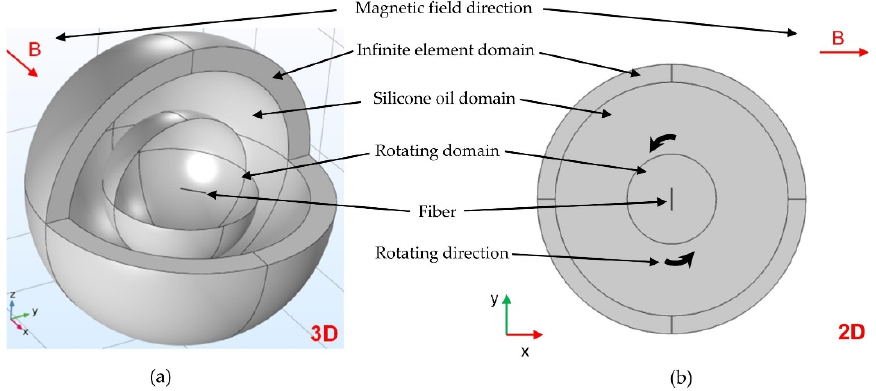
Figure 4. Reduction in the simulation model: ( a ) 3D model; ( b ) simplified 2D model.